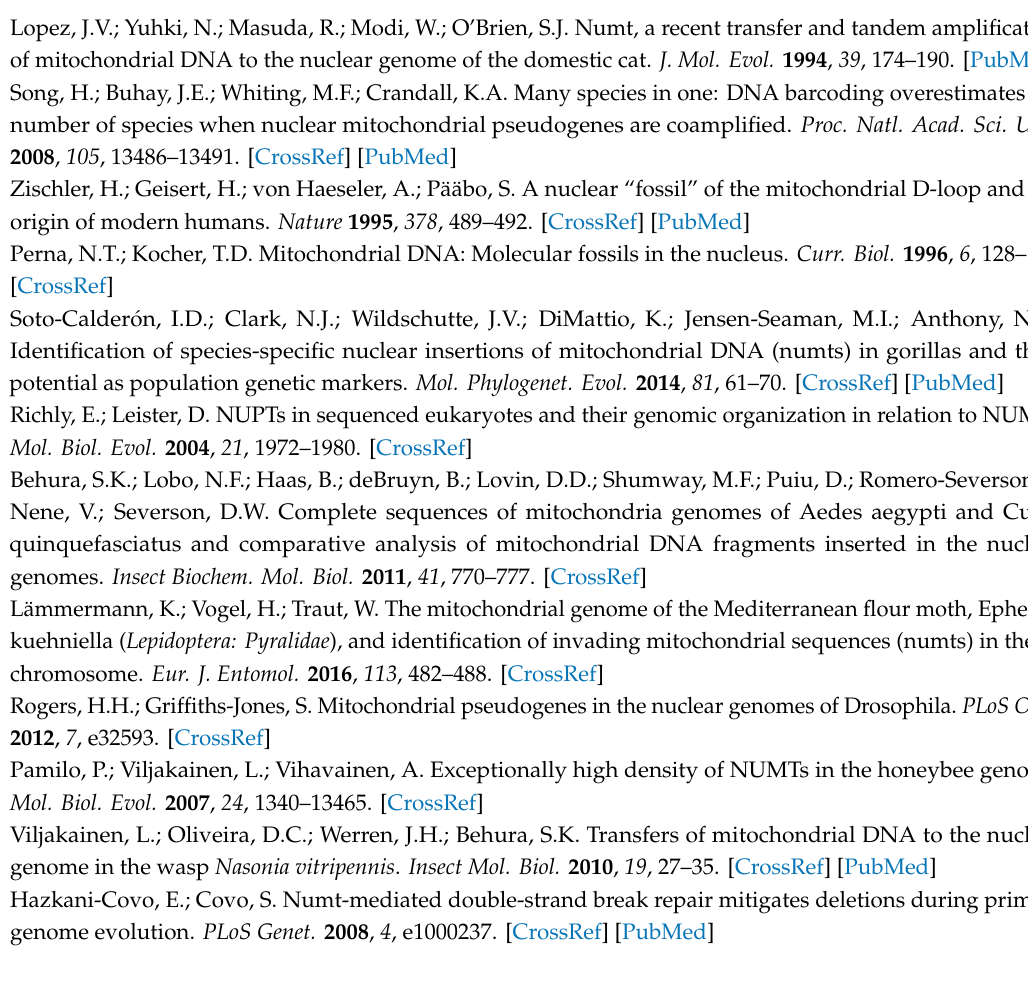
Table S1: The amount of NUMTs in fig wasp genomes, Supplementary material: NUMT